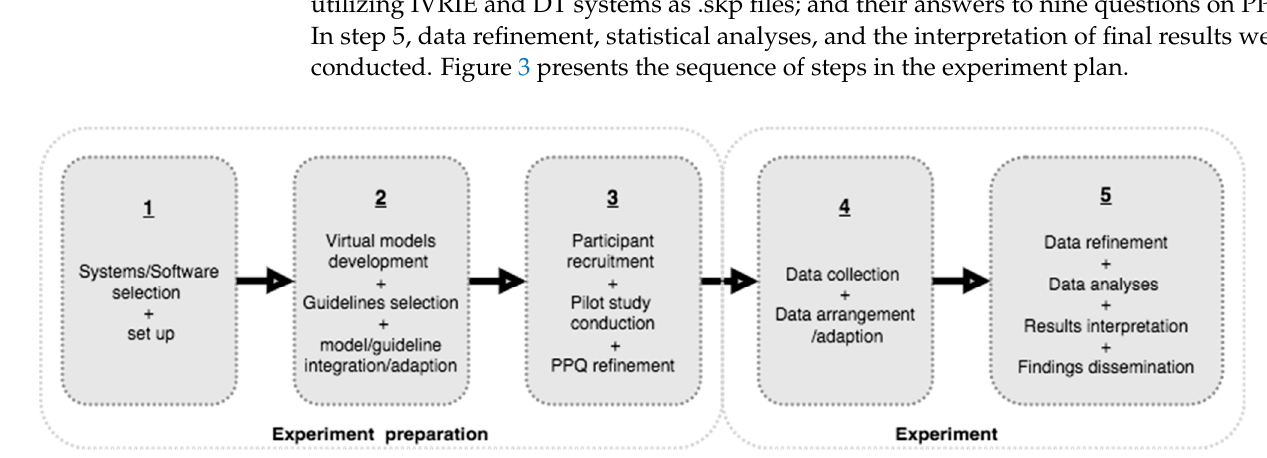
Figure 3. Flowchart of the experiment design.